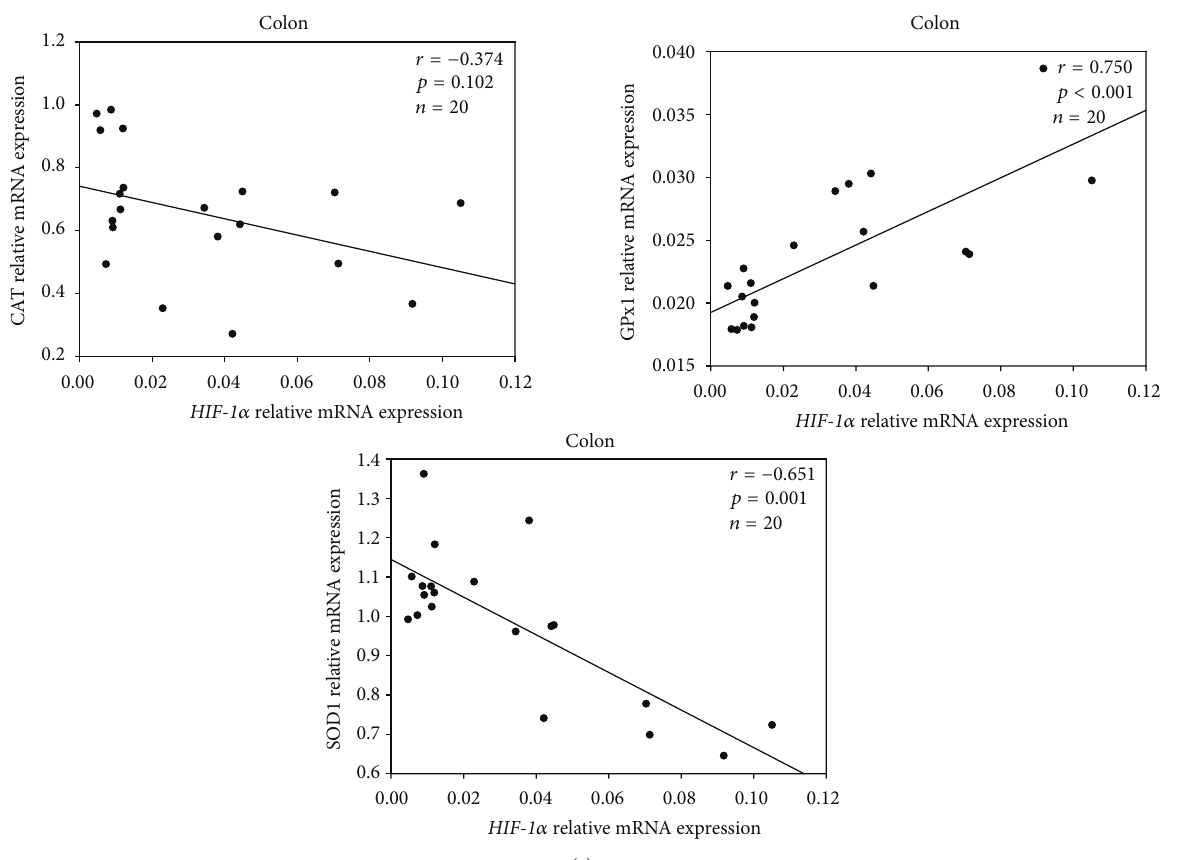
Figure 4: Relative mRNA expression of HIF-1 𝛼 , CAT , GPx1, and SOD1 in colon, MLN, and spleen (a, b) and their correlation to the HIF-1 𝛼 gene expression in colonic tissue (c). Relative mRNA expression was measured by real-time PCR; all measured genes were normalized to the HPRT1 gene expression. BALB/c mice at the age of 10–12 weeks were randomly assigned into 4 groups ( 𝑛 = min. 5/group/experiments): CTRL: control mice, CTRL + HBO 2 : control mice undergoing HBO 2 (60 min/2.4ATM, 2x/day, days 1–8), DSS: mice receiving dextran sodium sulphate (DSS, 5% w/v, days 1–7), and DSS + HBO 2 : DSS treated mice undergoing HBO 2 . Data are presented as mean ± s.e.m. of two independent experiments, each with min. 5 mice/group. ∗ Statistically different from CTRL, 𝑃 < 0.05 ; † statistically different from CTRL + HBO 2 , 𝑃 < 0.05